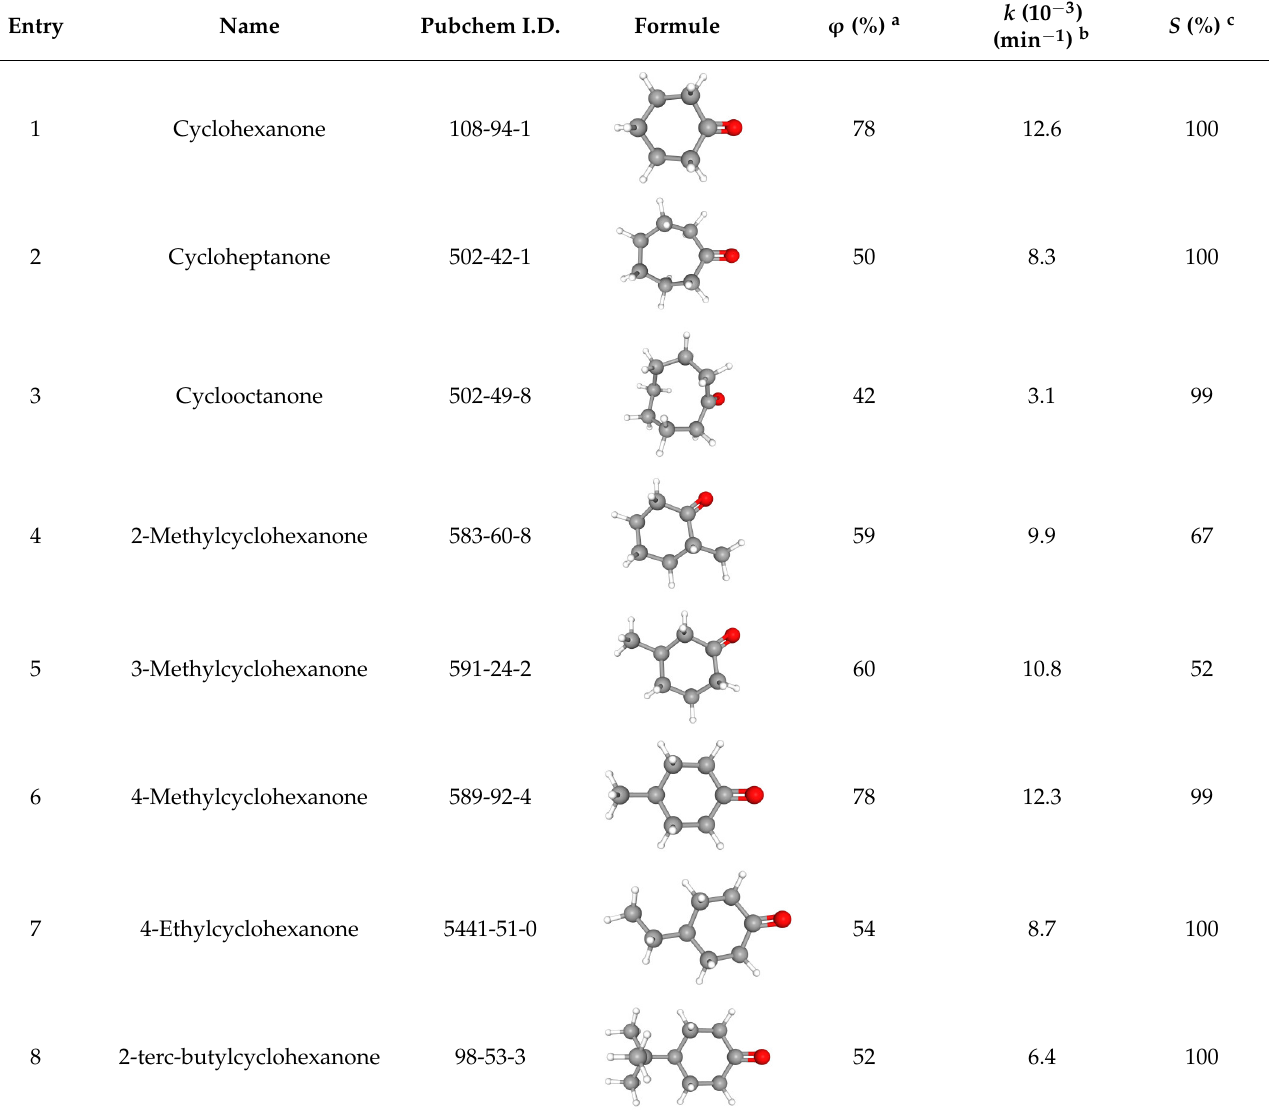
Table 3. Structure, conversion, rate constant and selectivity in selected Baeyer–Villiger reactions.